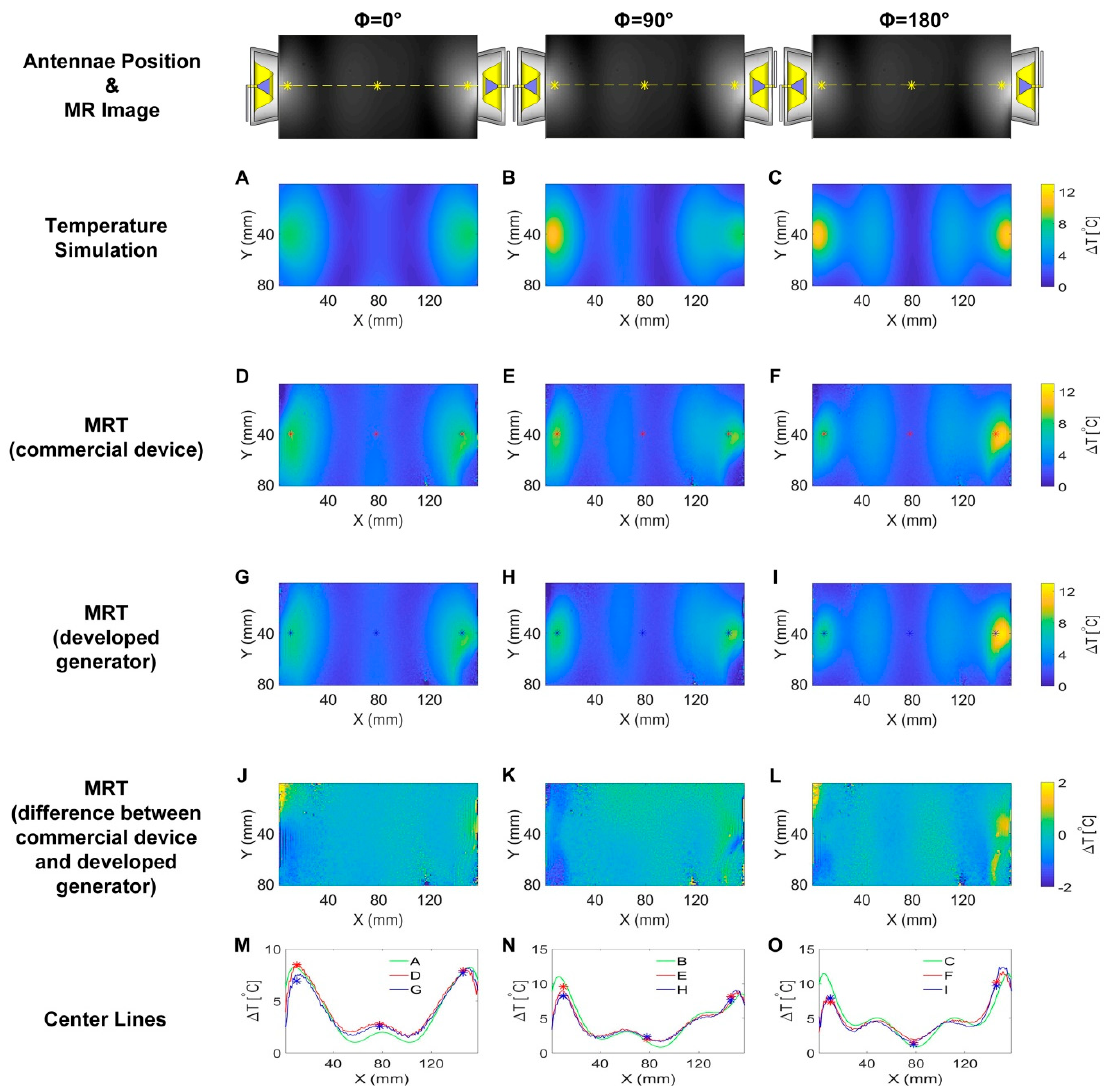
Figure 5. Maps of temperature changes ( ∆ T) obtained from the numerical simulations and experiments using two channels (f = 400 MHz) for RF heating (t = 10 min, P in at port = 17.78 W) with each channel being connected to an SGBT antenna. The first row demonstrates the position of the antennae and the MR image of the phantom. The yellow lines indicate the center lines and the yellow stars indicate the position of the fiber optic temperature sensor. Each column shows results obtained for one phase setting: φ = 0 ◦ , φ = 90 ◦ and φ = 180 ◦ . The phases were set to the right channel while the left channel was fixed to φ = 0 ◦ . A transversal slice in the middle of the phantom aligned with the center of the RF applicator was selected for MR thermometry. Figure ( A – C ) illustrate temperature changes obtained from temperature simulations. Figure ( D – F ) show maps of temperature changes derived from MRT for RF heating using the commercial signal generator (M8190A, Keysight). The red stars in these figures indicate the position of the fiber optic temperature sensor. Figure ( G – I ) depict maps of temperature changes deduced from MRT of RF heating using the signal generator developed in this work. The blue stars in these figures represent the position of the fiber optic temperature sensor. Figure ( J – L ) outline ∆ T di ff erence maps benchmarking the temperature changes obtained for RF heating using the proposed signal generator against those observed for the commercial M8190A signal generator. The bottom row (Figure ( M – O )) show ∆ T profiles obtained for a center line placed across the center slice of the phantom for temperature simulations ( A – C ), experimental RF heating using the commercial M8190A signal generator ( D – F ) and experimental RF heating employing the RF signal generator setup developed in this work ( G – I ). The blue stars and red stars indicate readings from the temperature sensor for heating with our signal generator and with M8190A, respectively. Constructive interference patterns were observed in the middle of the phantom for phase setting φ =